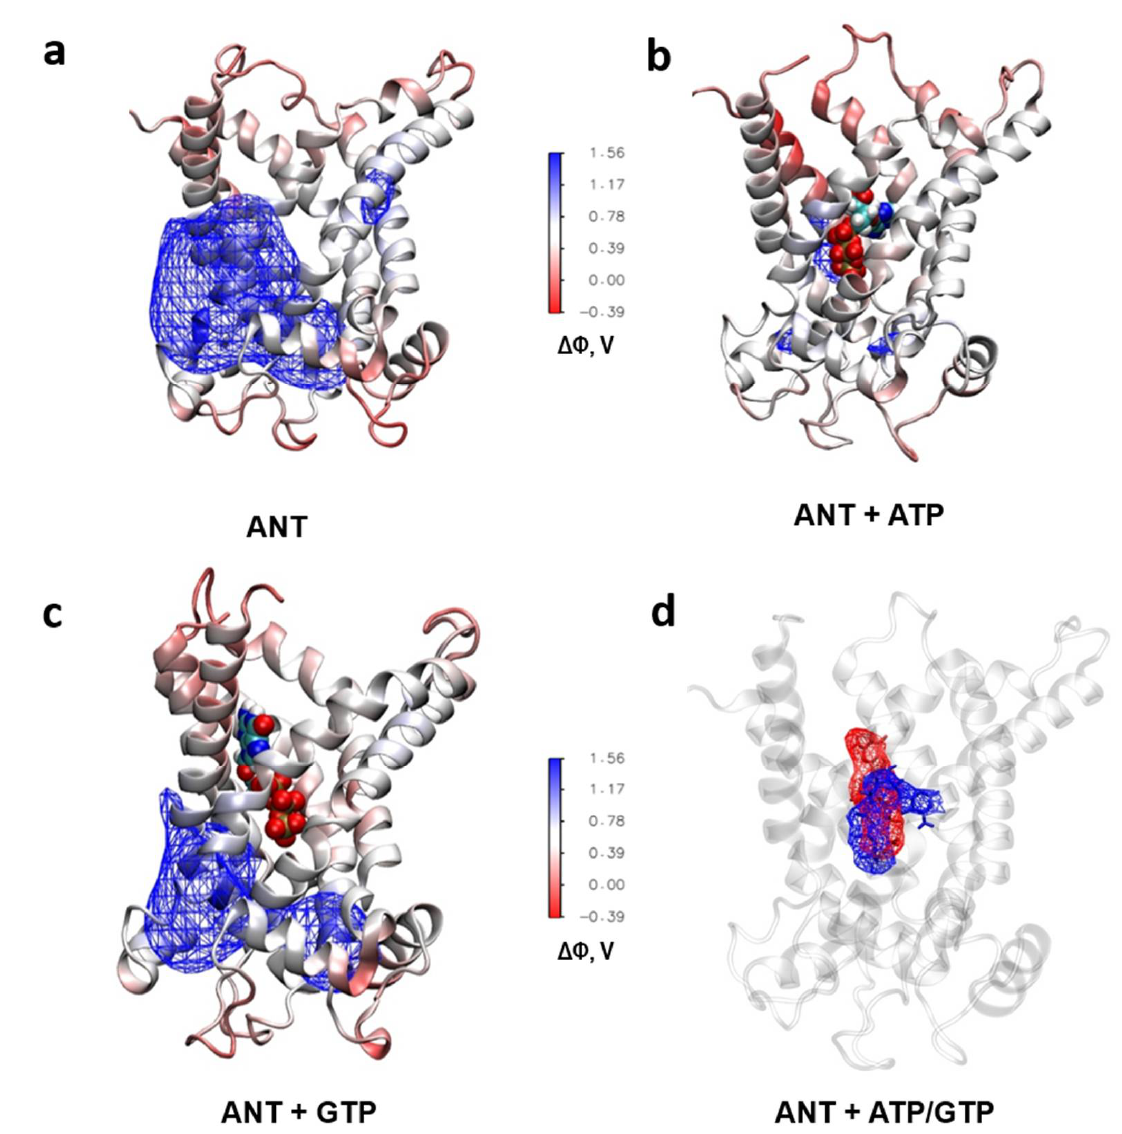
Figure 6. The purine nucleotides ATP and GTP differently modulate the electrostatic surface potential of ANT upon binding. ( a – c ) Electrostatic potential ( ∆ of ANT1 in the absence ( a ) and presence of bound ATP ( b ) and GTP ( c ) calculated by molecular dynamics simulations. The isosurface of the potential of 0.9 V is shown with the wireframe. ( d ) Different average binding location of ATP (blue wireframe) and GTP (red wireframe) in